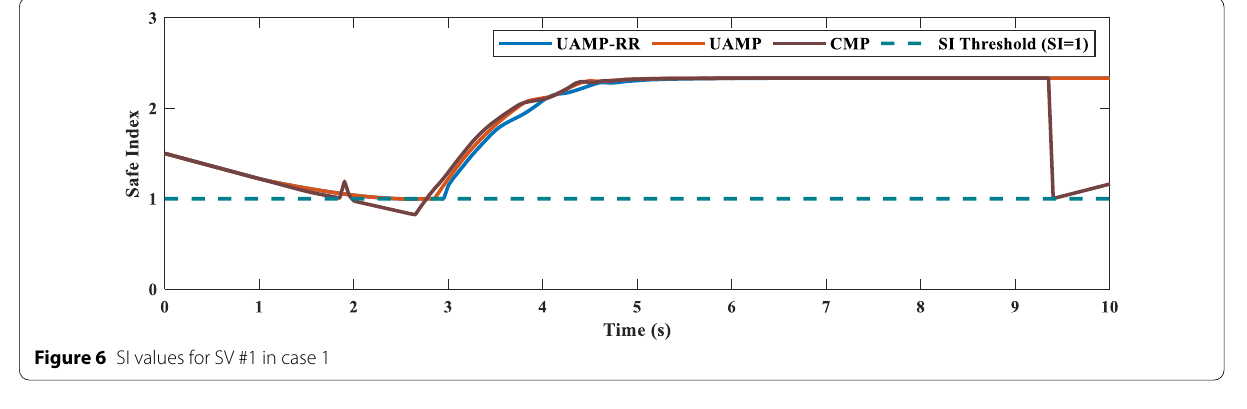
Figure 6 SI values for SV #1 in case 1